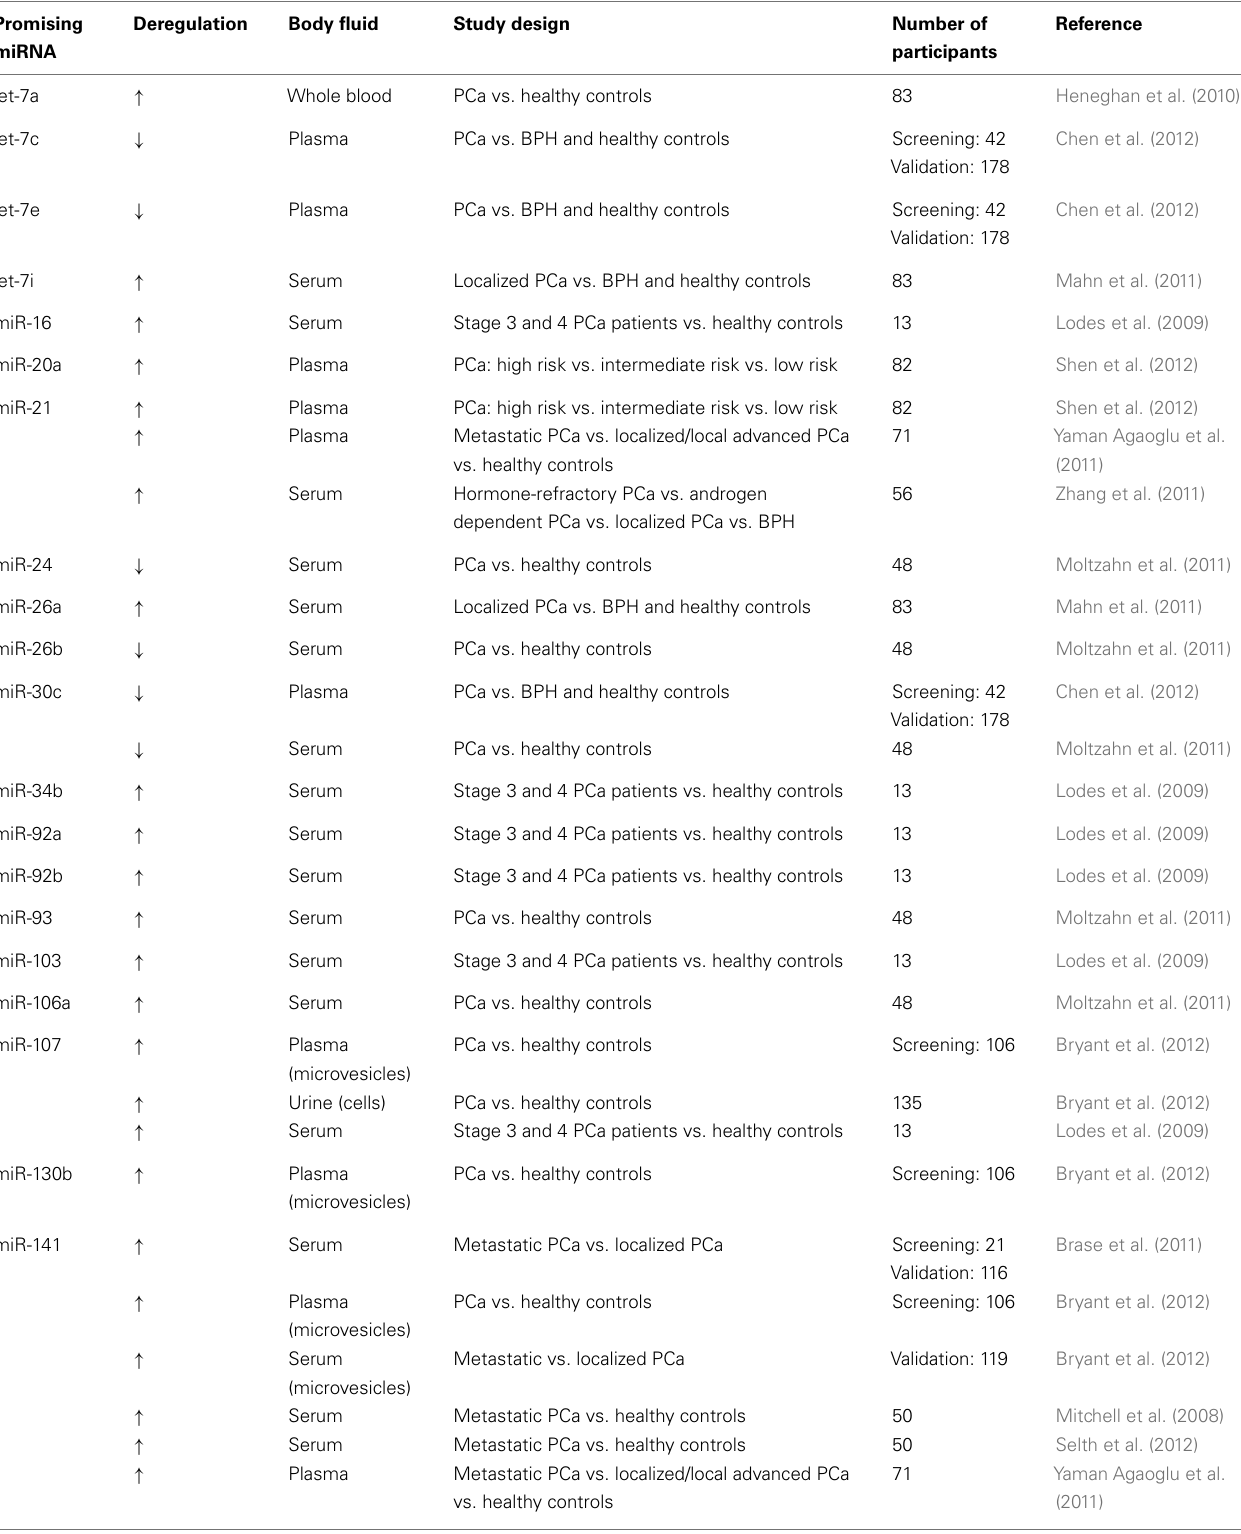
Table 1 | Studies of extracellular miRNAs in body fluids from prostate cancer patients. Promising Deregulation Study design Number miRNA